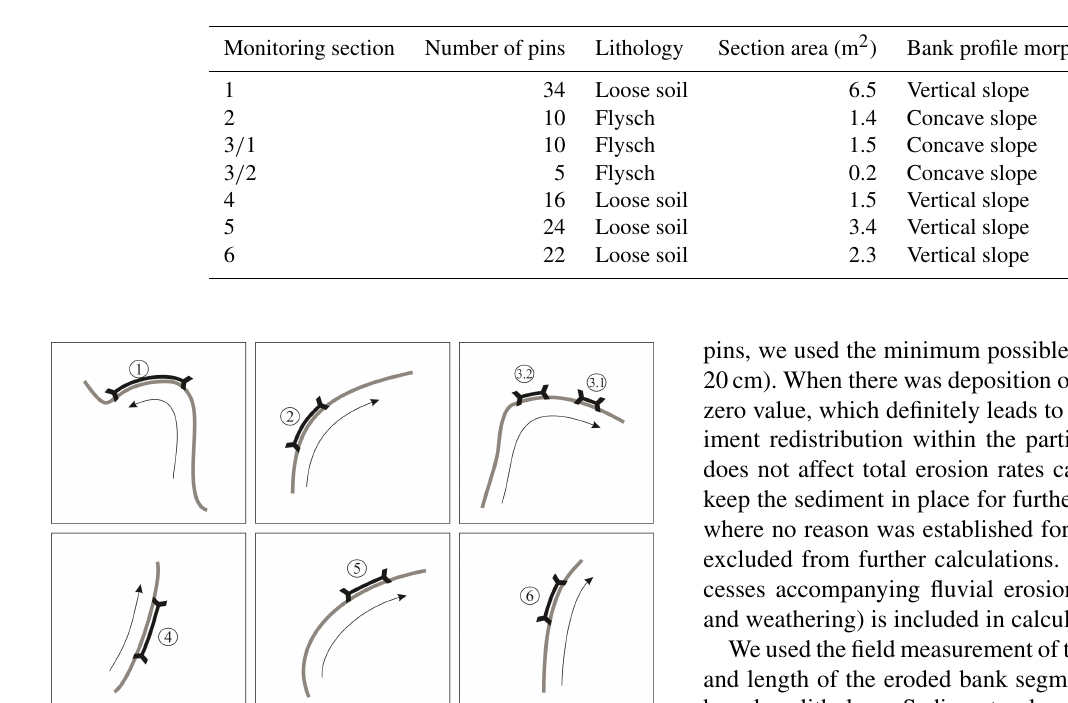
Figure 2. Channel bank types with major characteristics. Table 1. Monitoring river bank section characteristics.